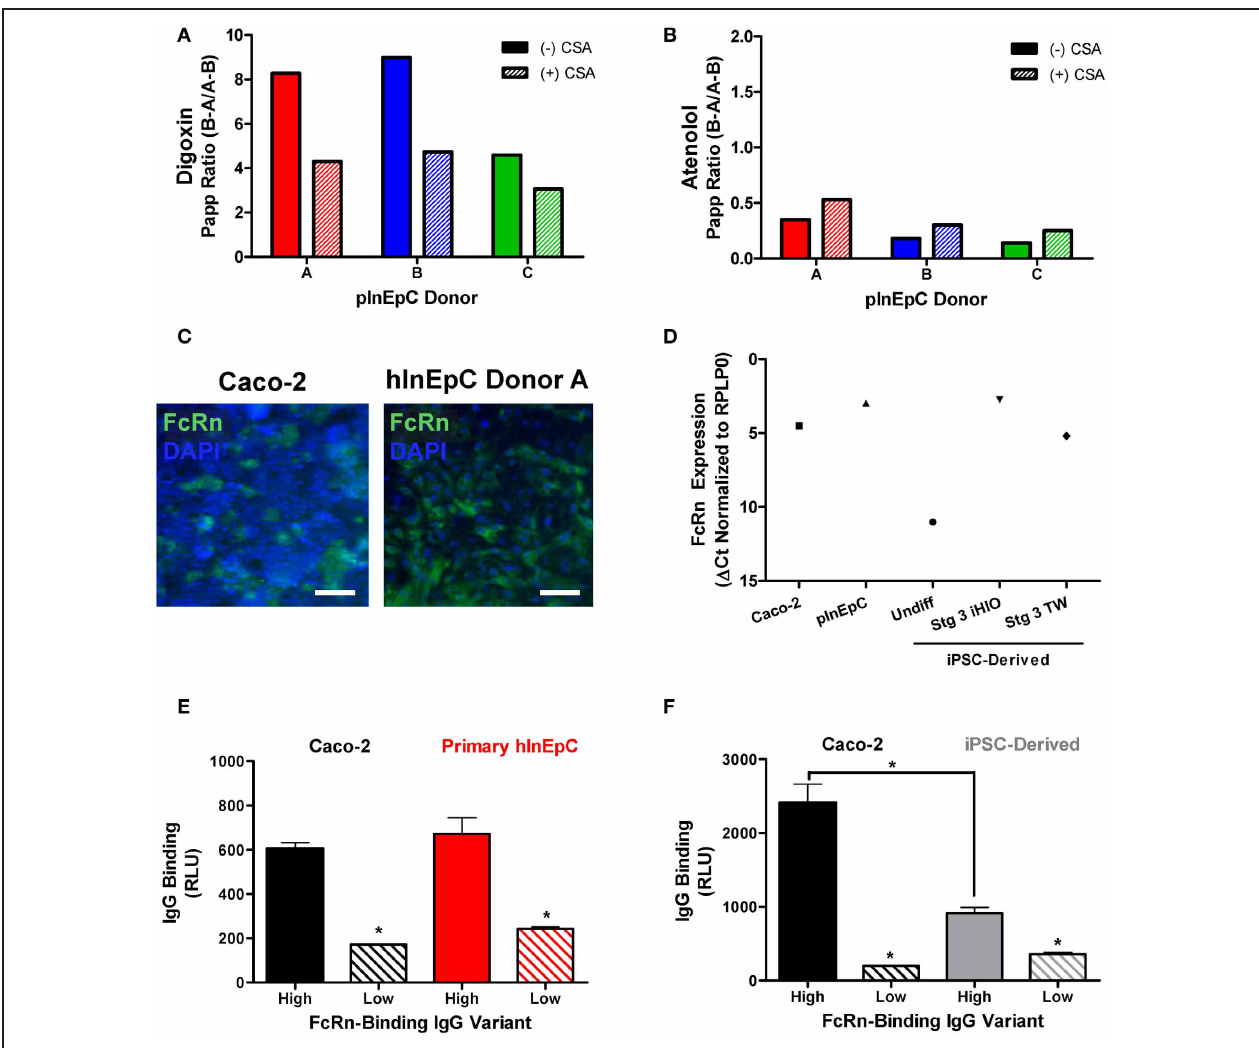
express FcRn mRNA levels similar to Caco-2, but lower than primary hInEpCs and iPSC-derived 3D induced human intestinal organoids (iHIOs). Caco-2 (E,F) , primary hInEpCs (E) and iPSC-derived transwell cells (F) show FcRn-dependent mAb binding by MSD assay, as demonstrated by statistically greater cell binding of high FcRn-binding IgG variants [High, N434A (E) or M428L (F) ] than low FcRn-binding variants (Low, H435A). N ≥ 4; Error bars represent SEM. (E,F) , statistical significance determined by t -test, ∗ p < 0 .